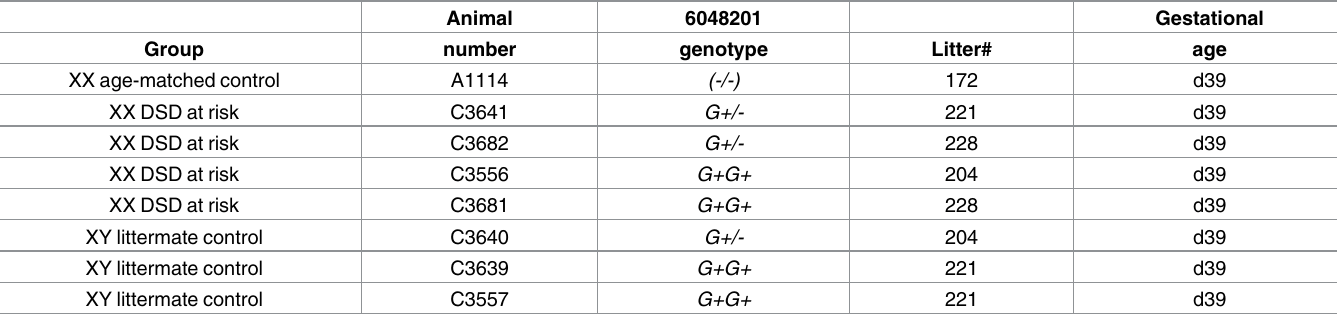
Table 6. Canine embryonic gonad pairs collected for